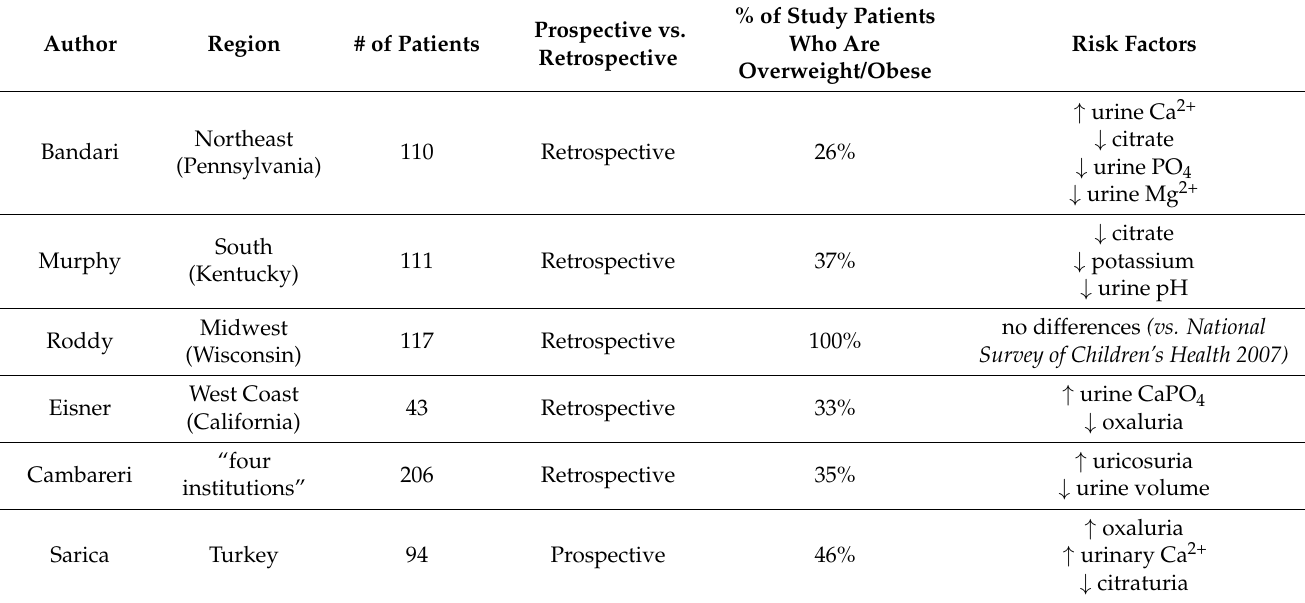
Table 3. The 24 h urine findings in obese patients by USA regions and